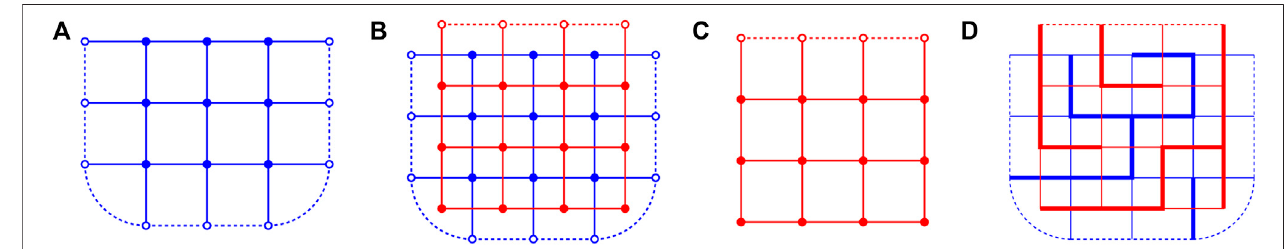
FIGURE 1| Drawing codesfor the three fi gures are asfollows. The open circle stands for the sink vertex, while the solid circles stand for the non-sink vertices. The solid lines represent true edges of the extended graphs, unlike the dashed lines connecting the open circles which indicate that these should be identi fi ed as the unique sink vertex. Let us note that the corner vertices which lie at the intersection of an open and a closed boundary have a single edge to the sink; those at the intersection of two open boundarieshave two such edges. (A) The left fi gure shows the extended graph ofa 3 × 3 grid withopen boundary conditions on theleft, lower, and right boundaries, and closed boundary condition on the upper boundary. (B) The second panel shows how the dual of the blue graph, in red, is constructed. The red sink is thevertexassociatedwiththeouterfaceofthebluegraph. (C) Forabetterreadability,thedualgraphaloneisreproducedonthethirdpanel. (D) Twodualspanningtrees are drawn on the far